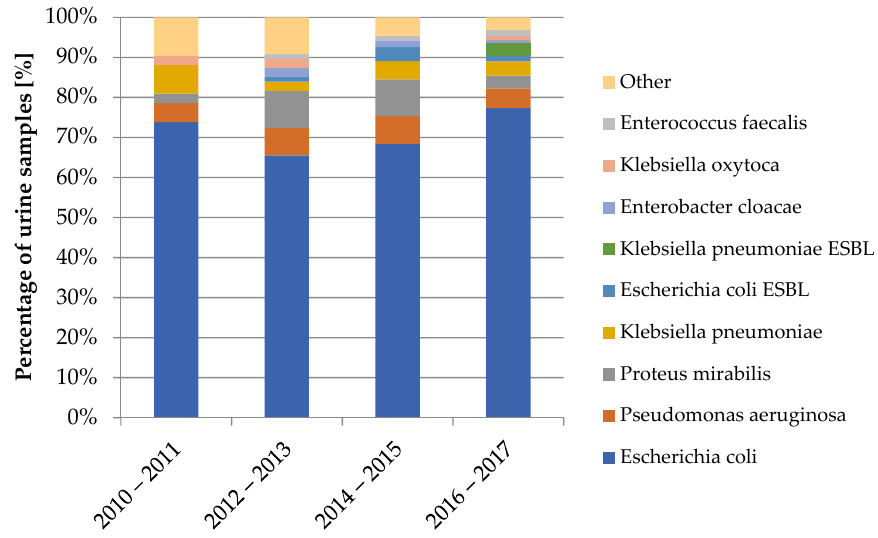
Figure 5. Variability of bacterial strains in the urine cultures from 2010–2017.